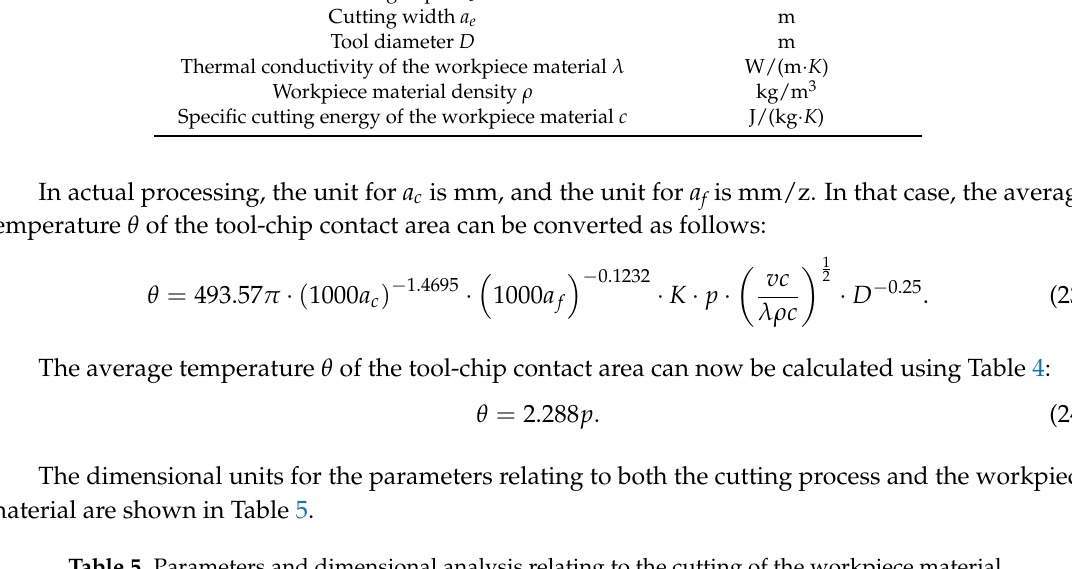
Table 5. Parameters and dimensional analysis relating to the cutting of the workpiece